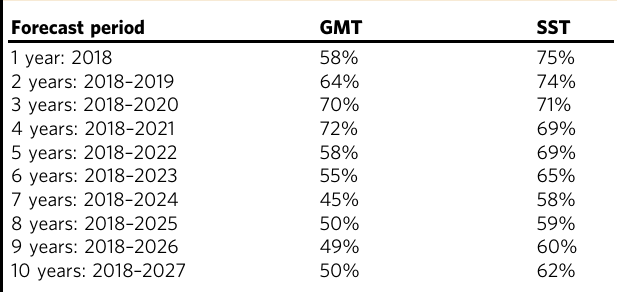
Table 1 Likelihood of anomalously warm years for the next decade Forecast